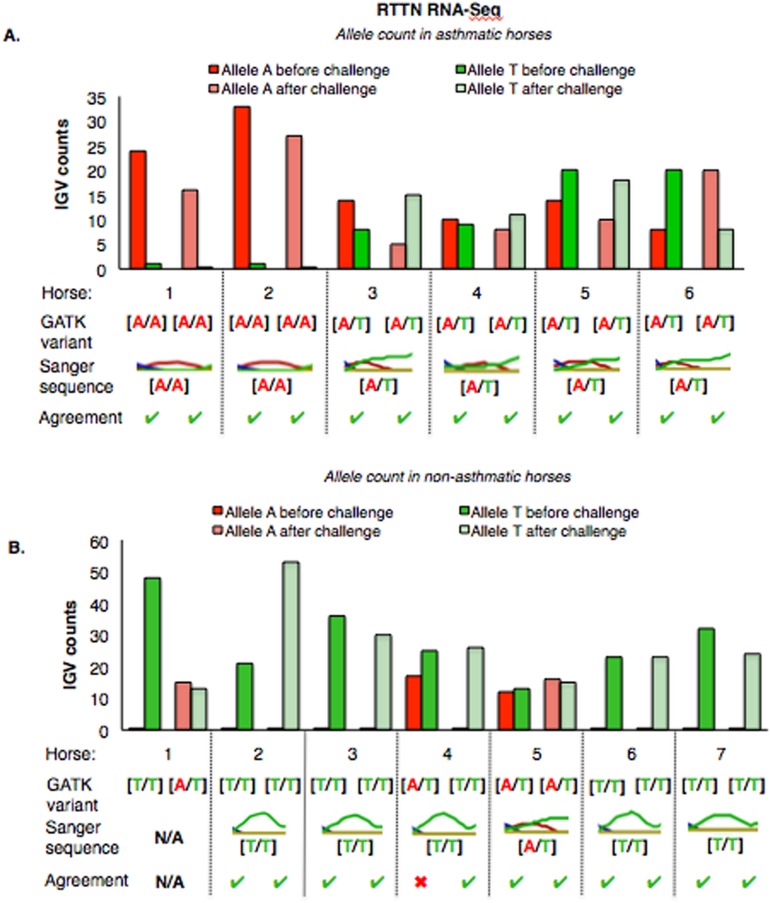
Comparison of GATK variant calls and Sanger sequencing results for RTTN in asthmatic (A) and non-asthmatic (B) horses.Details as in Fig. 5. (A) Four asthmatic horses (3–6) had heterozygous alleles [A/T] and two (1 and 2) were homozygous for the mutant allele [A/A]. Genotypes were consistent across horses and methods. (B) In non-asthmatic horses, one (5) had heterozygous [A/T] alleles, four horses had homozygous wild type [T/T] alleles, and two horses (1 and 4) were inconsistently identified as homozygous wild type and heterozygous in different samples. Sanger sequencing confirmed the genotype of horse 4 as heterozygous. DNA was not available for non-asthmatic horse 1.